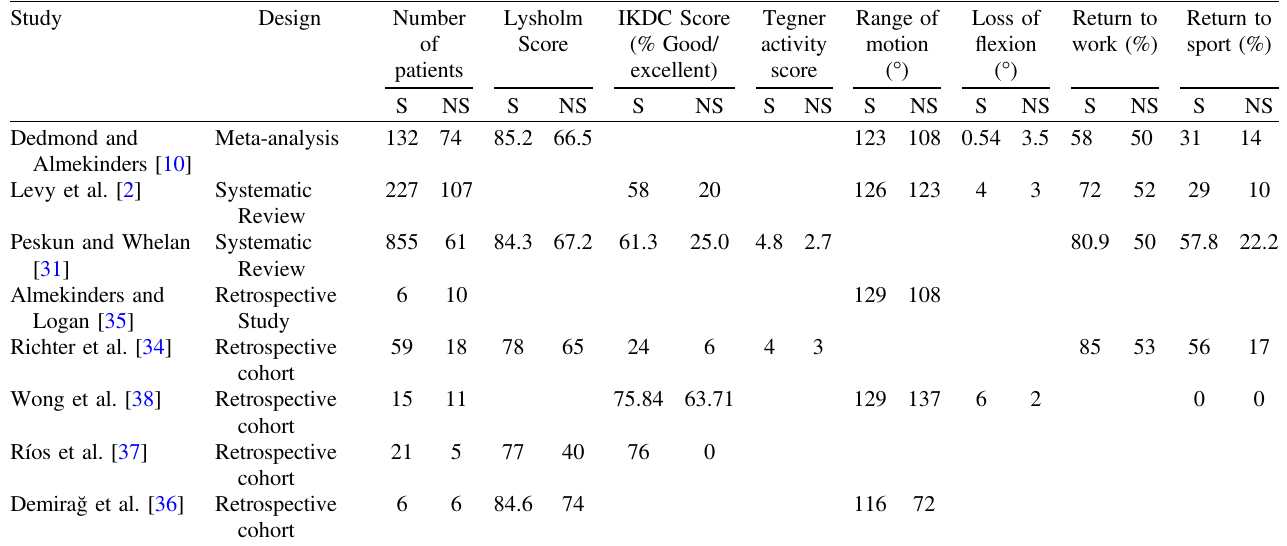
Table 2. Outcome comparison of surgical versus nonsurgical treatment [2, 10, 31, 34 – 38].